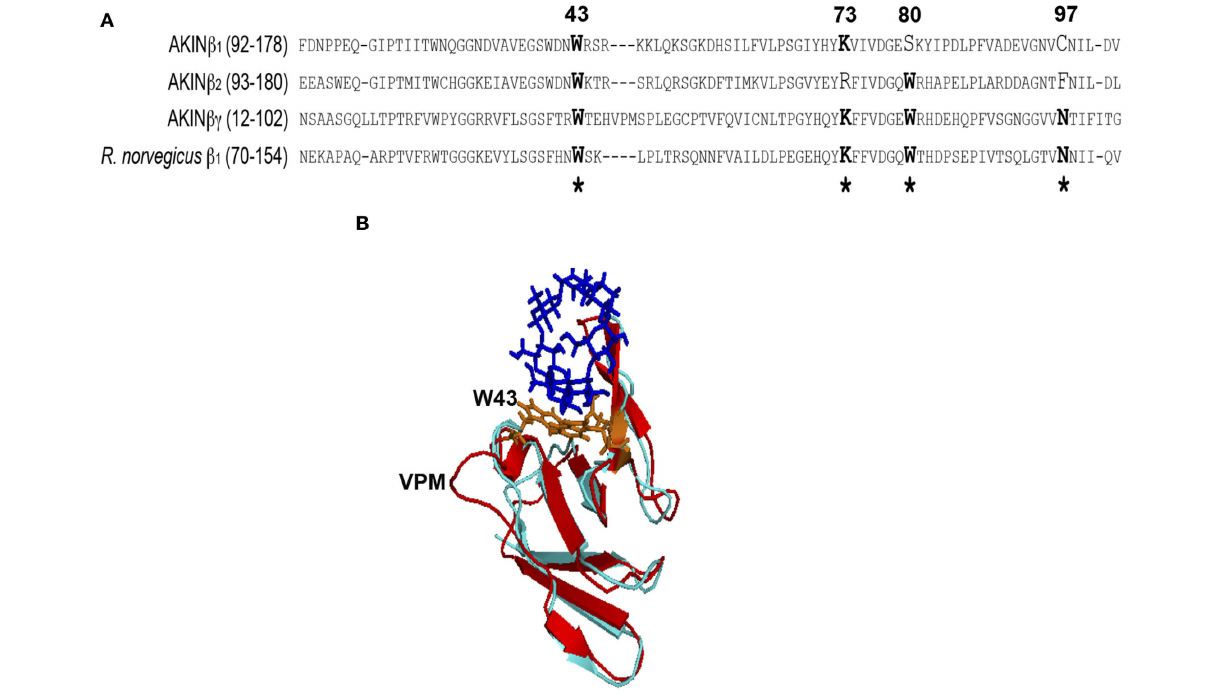
models generated with AKIN β 2 (light blue) and AKIN βγ (red) where the insertion of the three amino acids (VPM) is indicated. The structure of the β -ciclodextrin is showed in dark blue and the conserved tryptophans in orange. ∗ Indicates the conserved critical residues for protein-carbohydrate interaction.